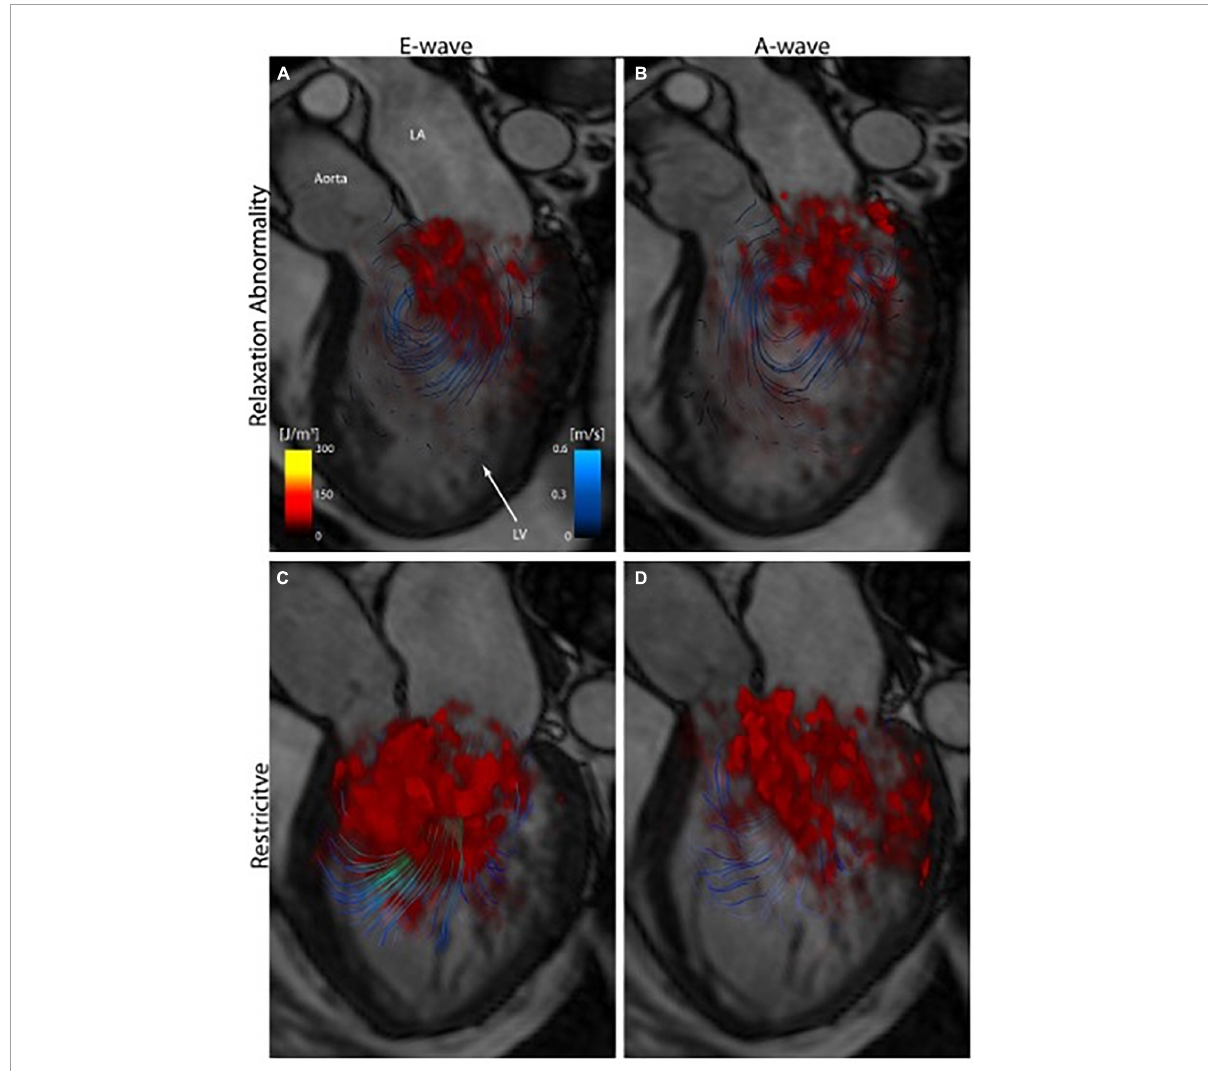
FIGURE4 3D volume rendering of turbulent kinetic energy (TKE) (red) in early (E-wave) and late (A-wave) diastolic filling of patients with grade 1 diastolic dysfunction (relaxation abnormality)-top, and grade 3–4 (restrictive filling)-bottom, showing significantly greater turbulent kinetic energy with greater diastolic dysfunction